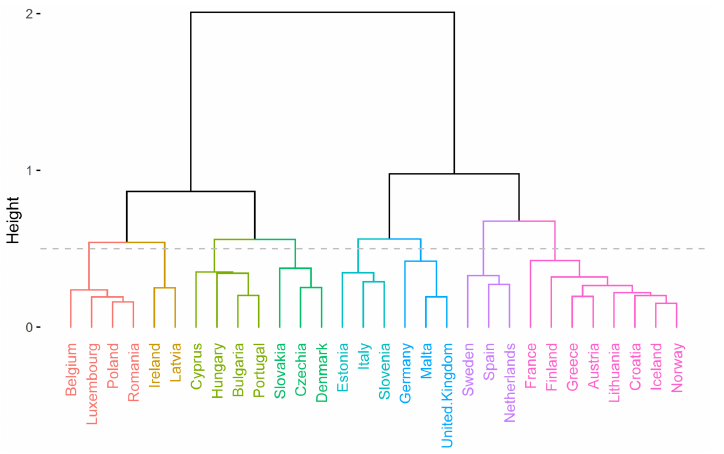
Figure 1. Clusters of countries with respect to relative dynamics of the degree of SDG7 implementa- tion. Source: own elaboration.